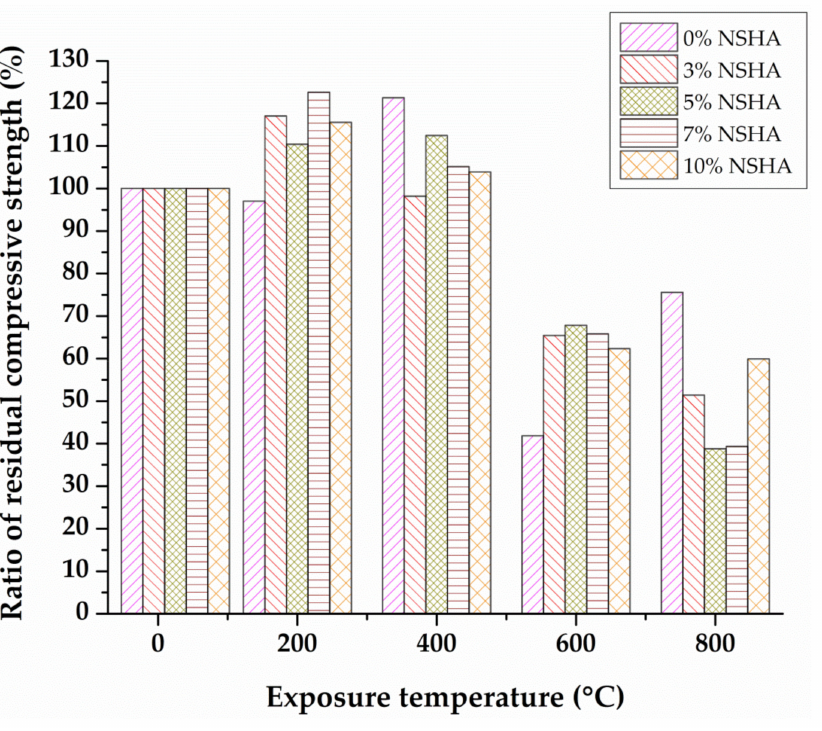
Figure 7. The ratio of residual compressive strength for the 7 days cured concrete.